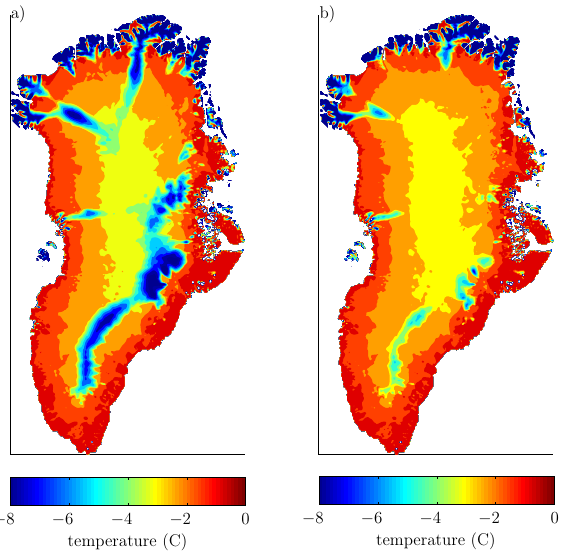
Figure 8. Preindustrial basal temperatures for both transient (a) and equilibrium spin-up (b)